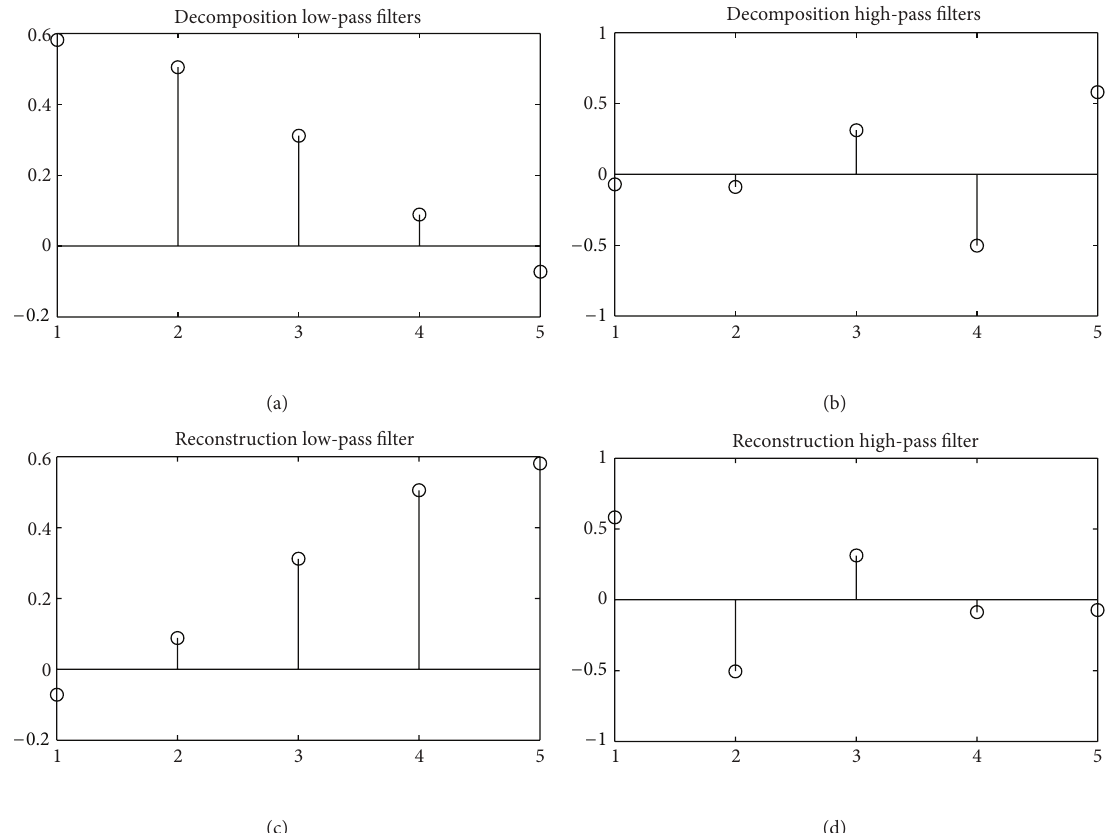
Figure 6: Impulse response for the reconstruction and decomposition filters of